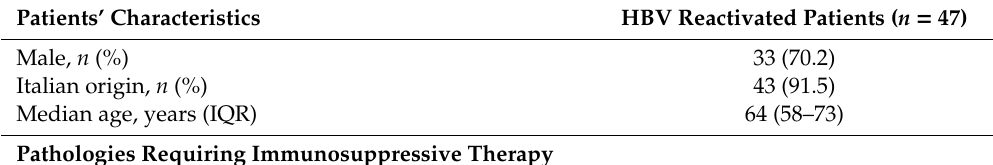
Table 1. Patients’